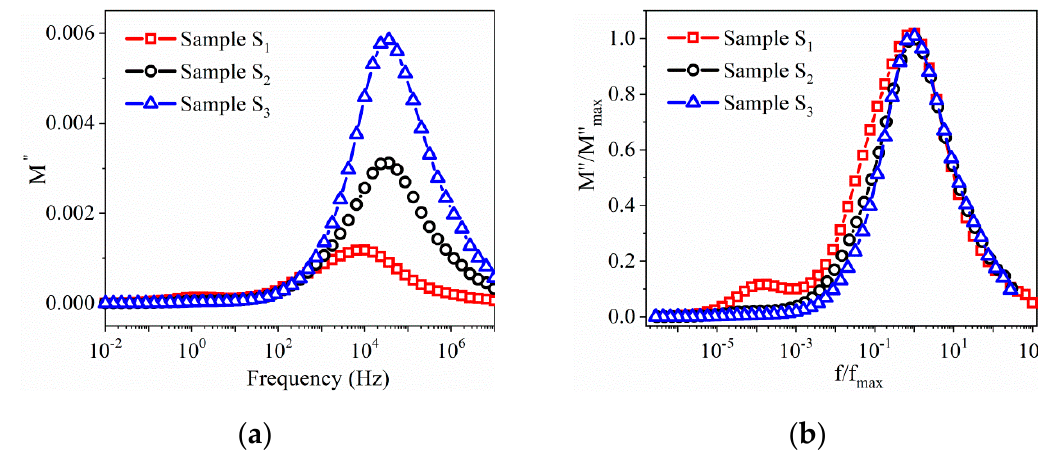
Figure 10. ( a ) Frequency dependence of imaginary part ( M ʺ ) of the dielectric modulus; ( b ) the normalized plots ( M ″ / M ″ max) versus log ( f / f max